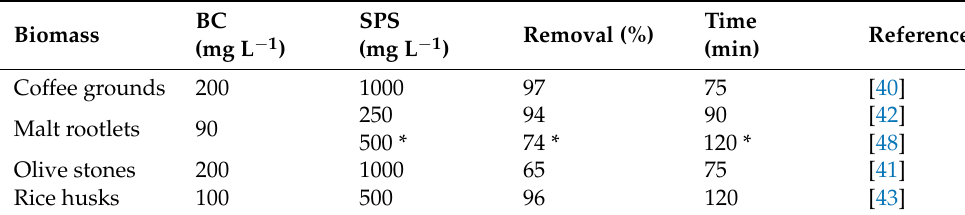
Table 1. Removal of SMX with biochar from different biomasses pyrolyzed at 850 °C. Values with asterisks refer to an experiment with trimethoprim as the target compound.